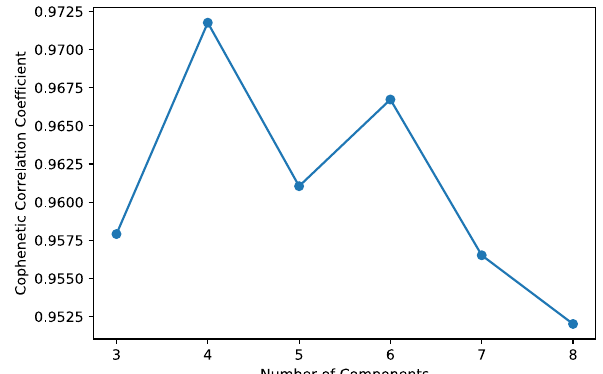
Figure 5. Cophenetic correlation coefficient versus the number of